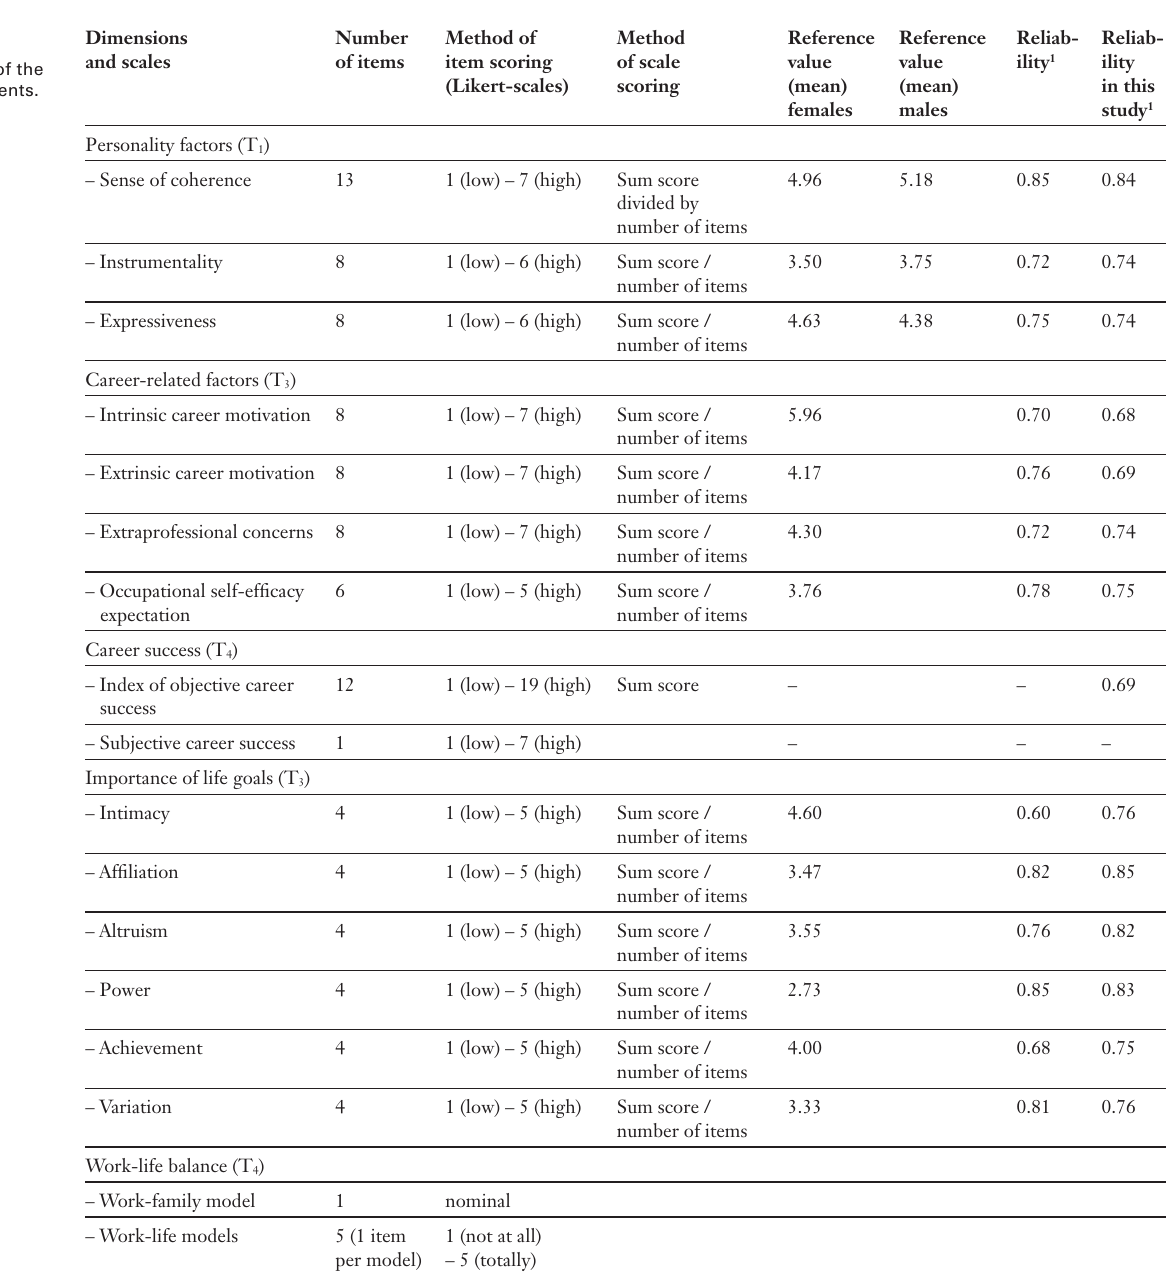
Characteristics of the applied